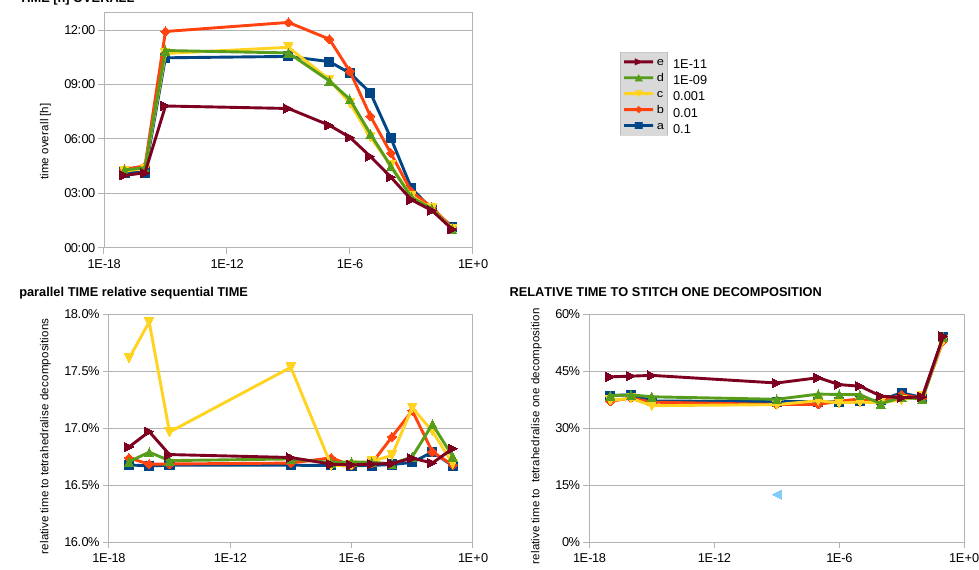
Figure 12. Results with six threads for the set of groups and three threads for each group of the city centre of Erfurt for grouping each building or building parts into separate groups ( x -axis: angular precision ζ , different colours for each precision (cid:101) = ε = σ = λ